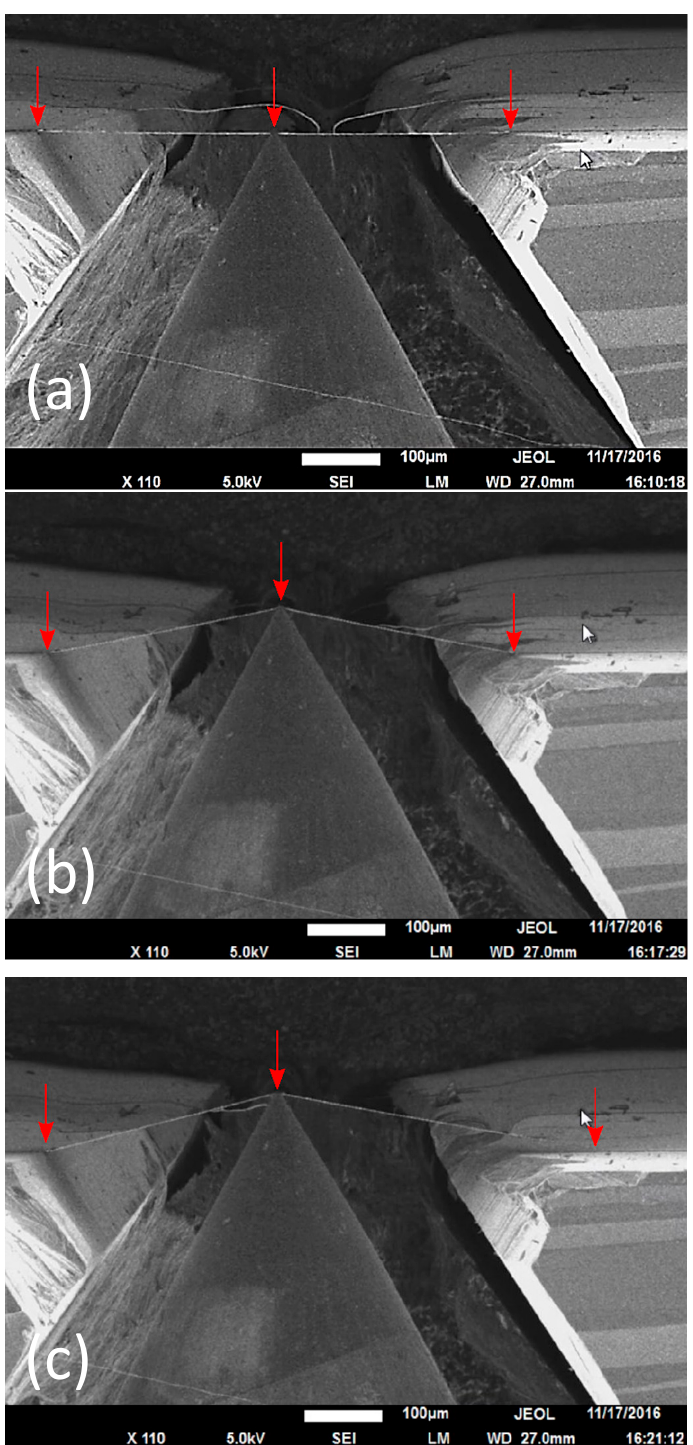
Figure 2. Scanning electron microscopy (SEM) movie frames depicting the delamination of individual PVDF electrospun fiber from silicon substrate. After the initial contact of the fiber with indenter tip ( a ); the fiber is stretched ( b ) and delaminated from substrate ( c ). Red arrows indicate the contact points of the fiber and substrate/indenter tip.